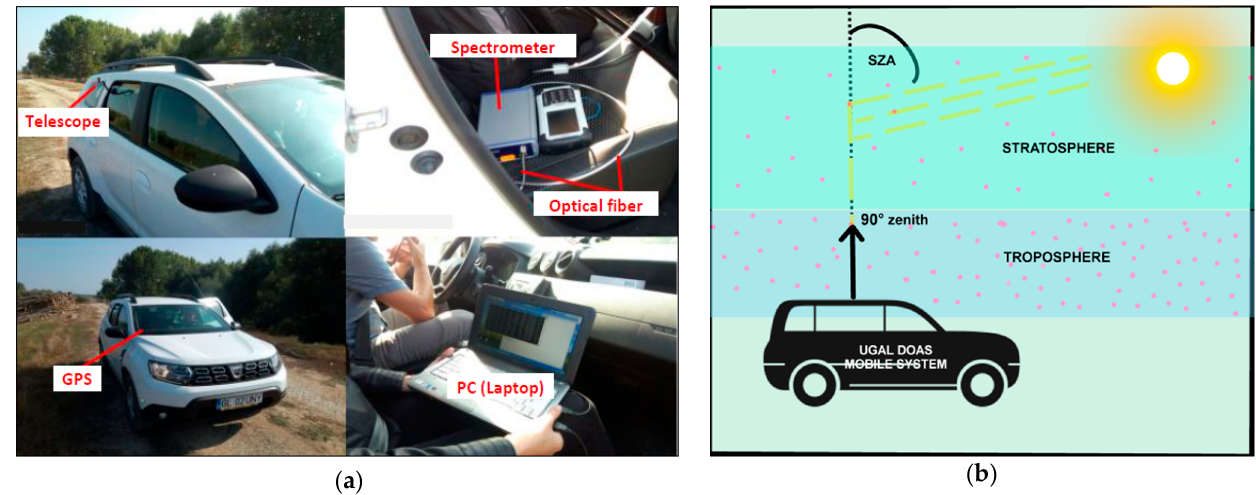
Figure 1. The UGAL mobile differential optical absorption spectroscopy (DOAS) system: ( a ) The components of the UGAL mobile DOAS system; ( b ) Principle of retrieval of NO 2 amount by mobile DOAS technique [12–14,17]; (SZA = Solar Zenith Angle).